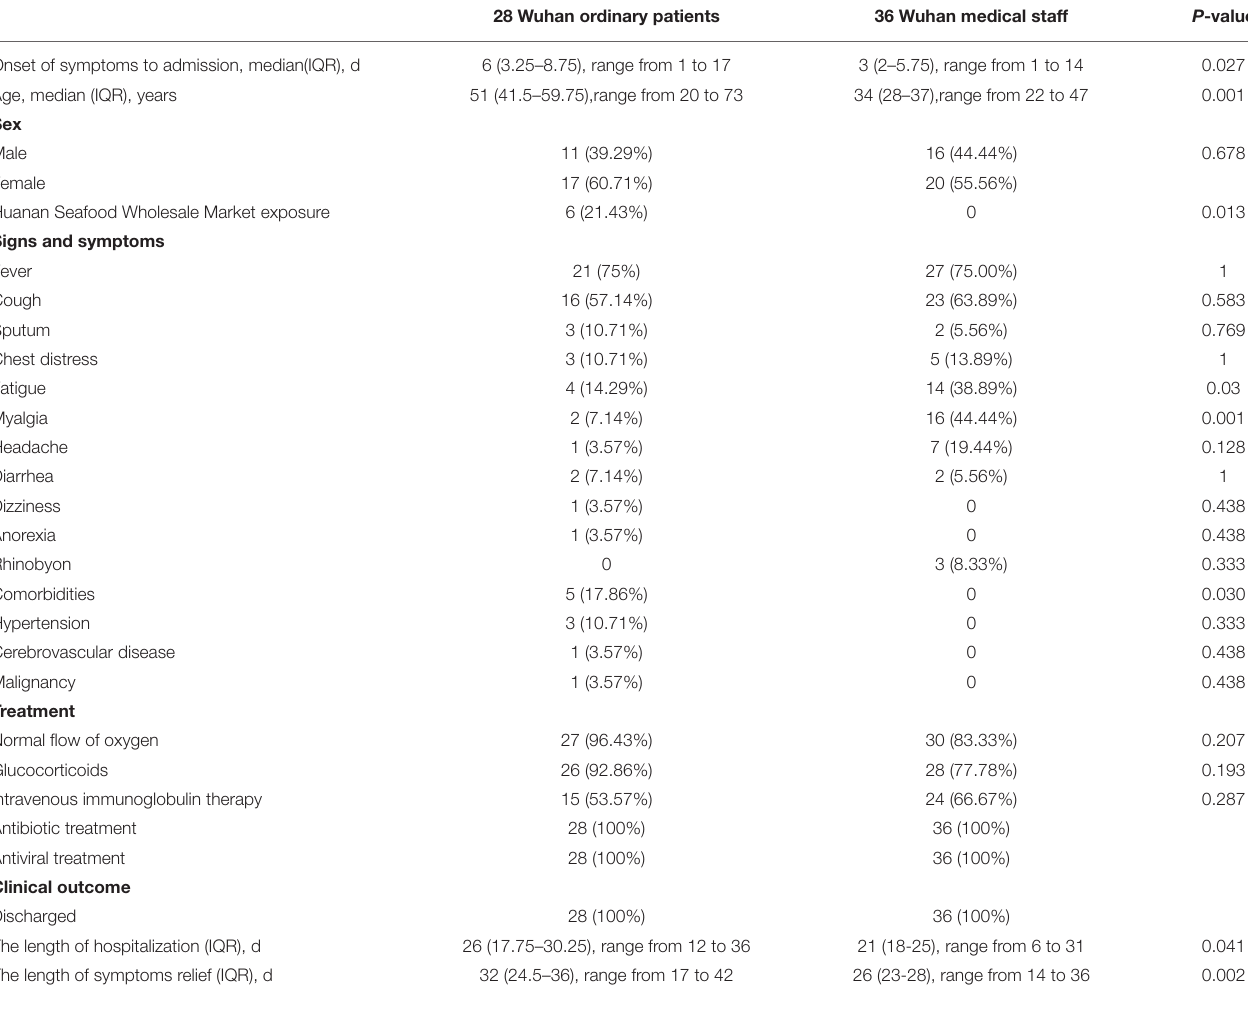
TABLE 1 | Demographic, clinical characteristics, treatment, and outcome of inpatients with moderate-type COVID-19 from